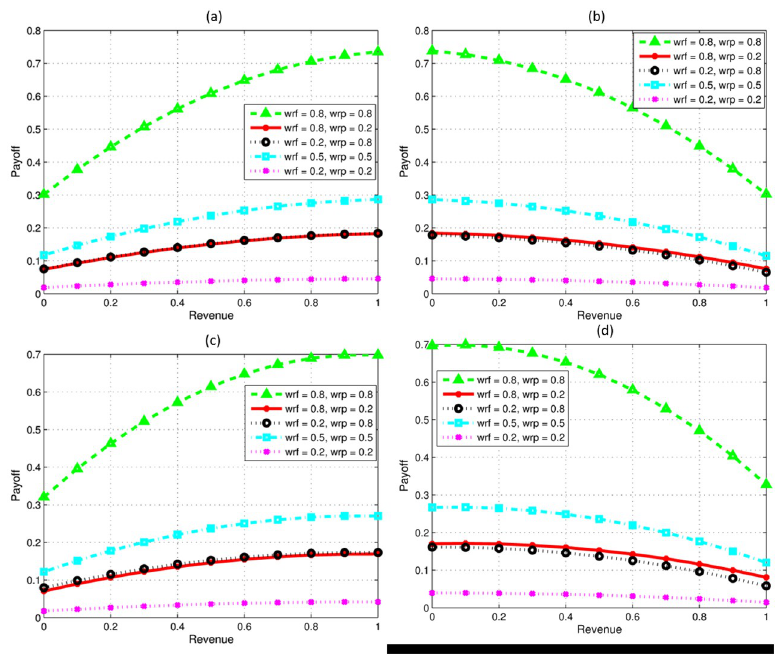
Fig 2. Impact of the individual objectives of firms over financial revenue and learning payoff. (a) F has high knowledge investment. (b) Fig 2b. P has high knowledge investment. (c) F has high investment and technical skills. (d) P has high investment and technical